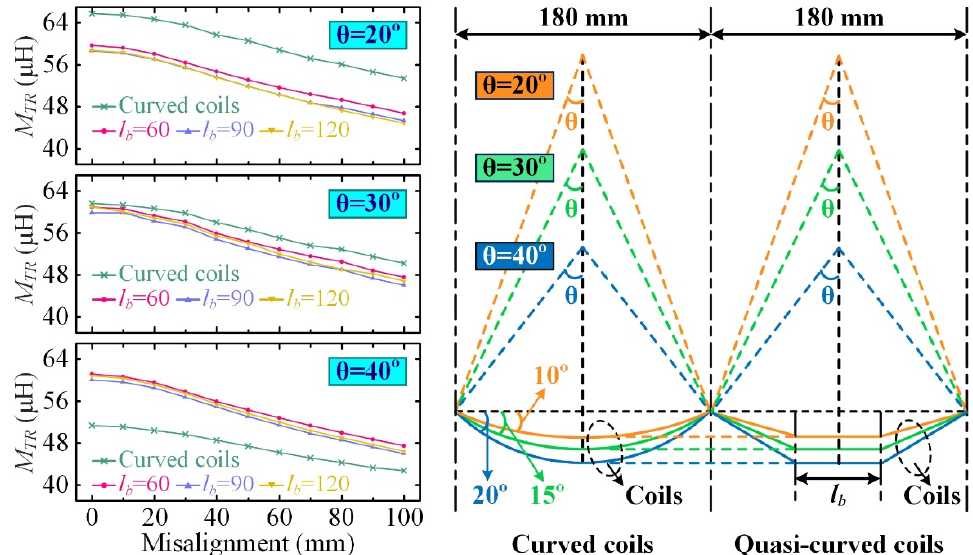
Figure 11. Comparison of curved coils and quasi-curved coils of the same θ .